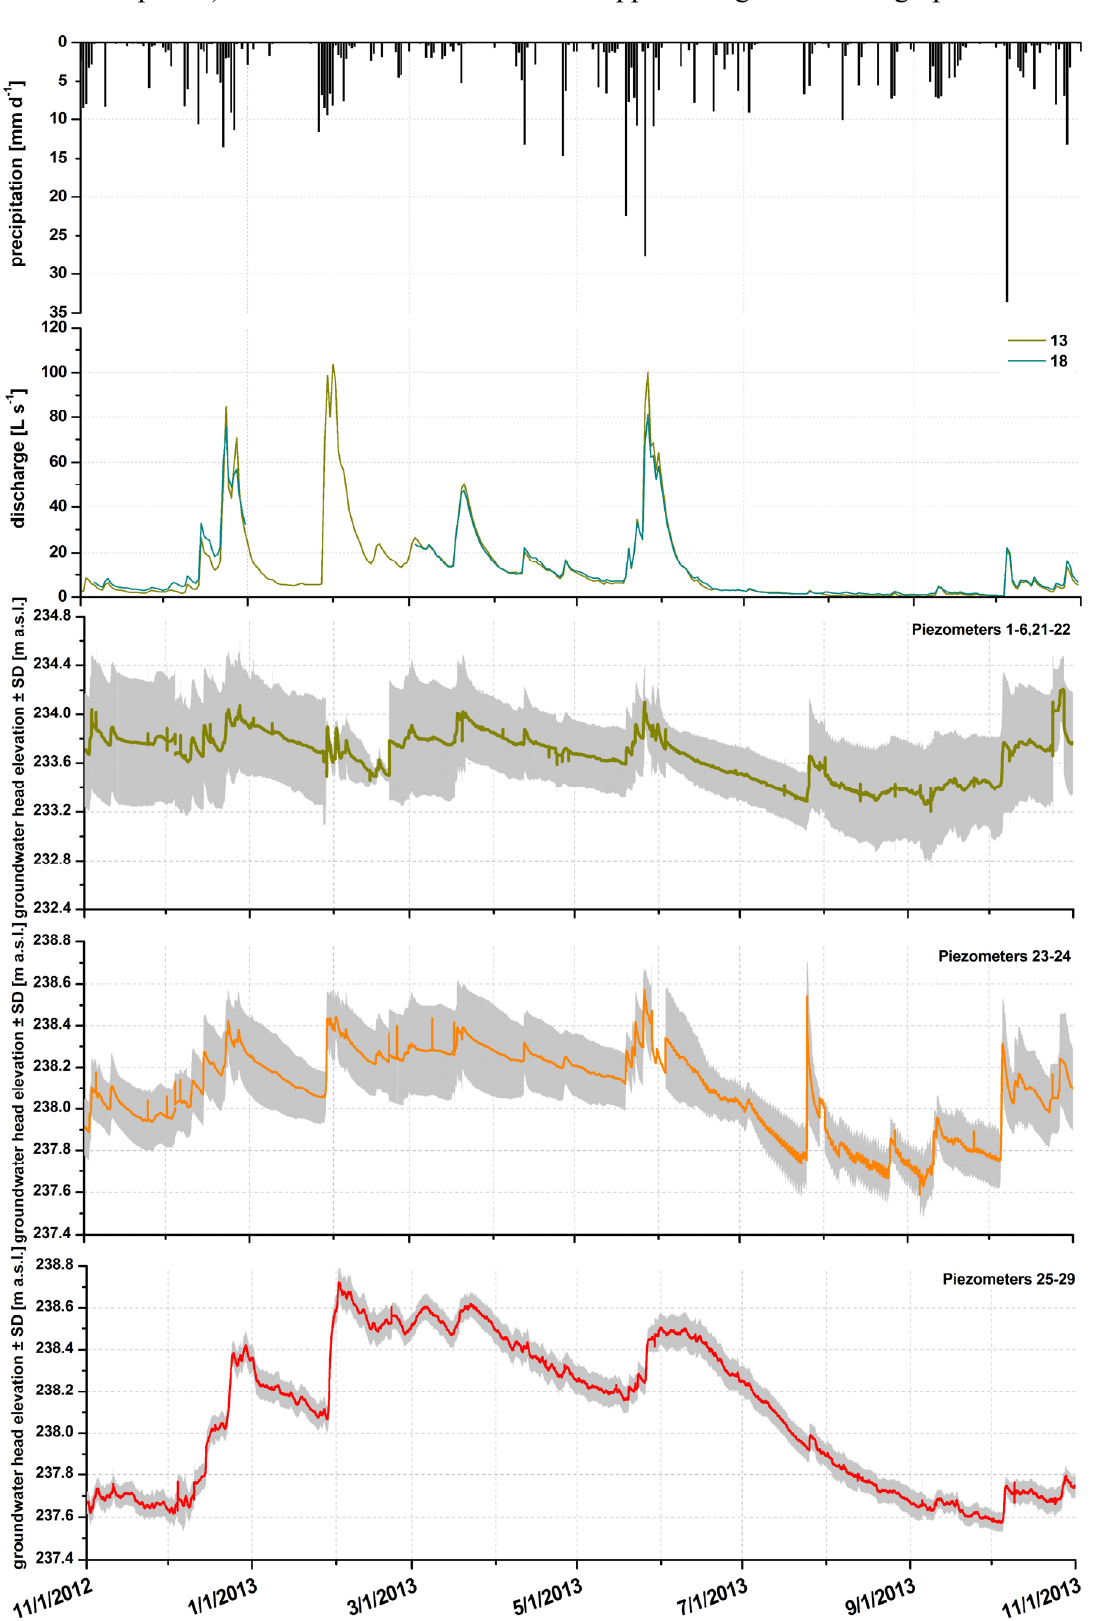
Figure 12. Time series of daily precipitation (mm·d − 1 ), discharge at the lower and upper RBC-flume (13, 18) (L·s − 1 ), and 15 min-mean groundwater head elevations (m a.s.l.) ±SD (grey shaded) for the water year 2012–2013 (if only data for one piezometer were available, no SD is depicted). Note the different scale of the uppermost groundwater